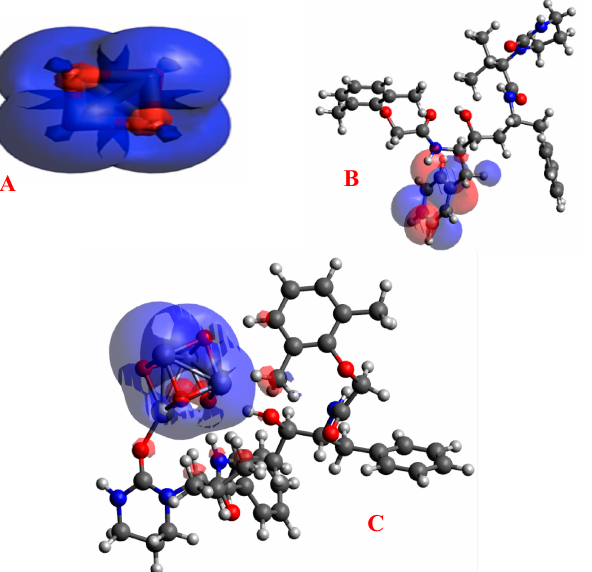
Figure 3. Lowest unoccupied molecular orbitals (LUMO) surfaces for the ( A ) ZnO-NP, ( B ) Lop and Figure 3 . Lowest unoccupied molecular orbitals (LUMO) surfaces for the ( A ) ZnO ‐ NP, ( B ) Lop ( C ) (ZnO) 4 -Lop (Isovalue of 0.01). and ( C ) (ZnO) 4 ‐ Lop (Isovalue of 0.01).